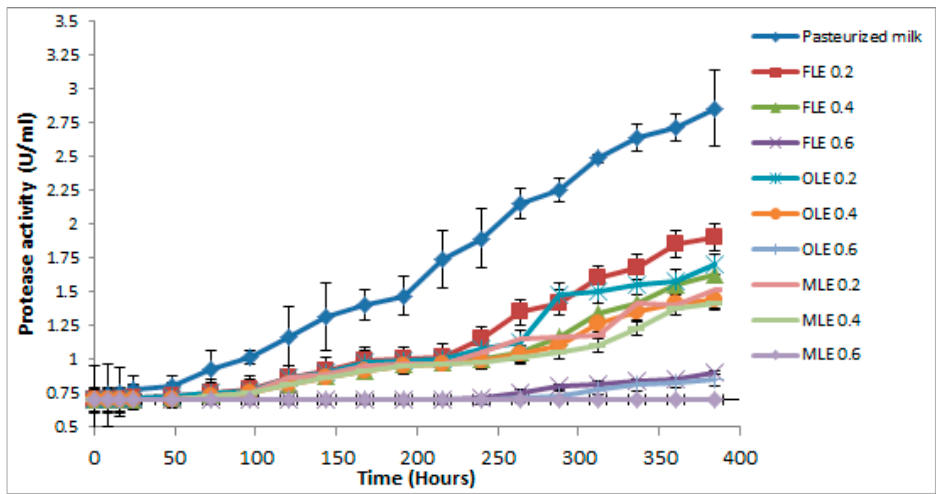
Figure 5. Observed average shelf stability of pasteurized buffalo milk enriched with FLE, OLE, and MLE, using activity of protease at 5 °C for 16 days. Vertical bars show the standard error of the samples mean.